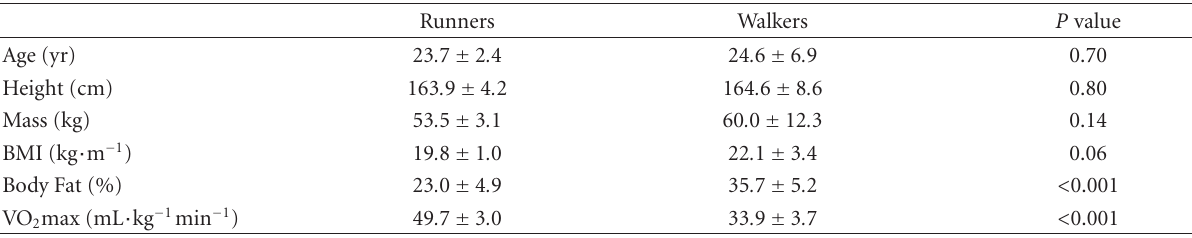
Table 1: Baseline preexercise characteristics for 9 female runners and 10 female walkers. Data are presented as mean ± SD. Body fat